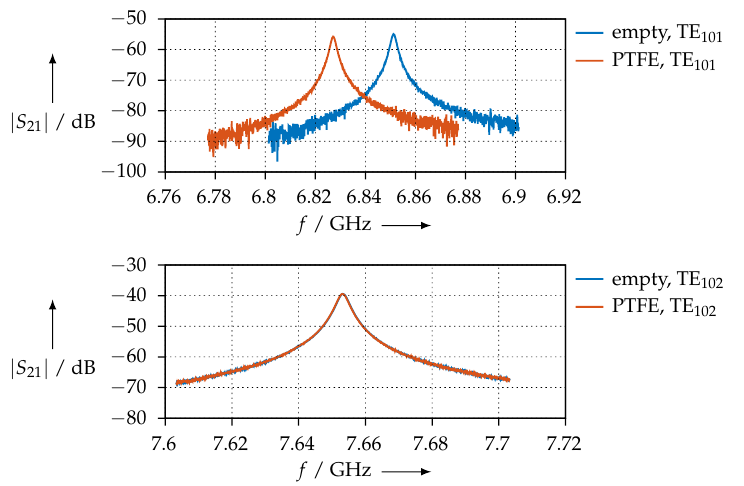
Figure 5. Waveguide rectangular resonator with schematic representation of the electric (red lines) and magnetic (blue lines) field distributions for different modes. ( a ) TE 101 mode, p = 1; ( b ) TE 102 mode, p = 2; ( c ) TE 103 mode, p = 3; ( d ) TE 104 mode, p = 4.